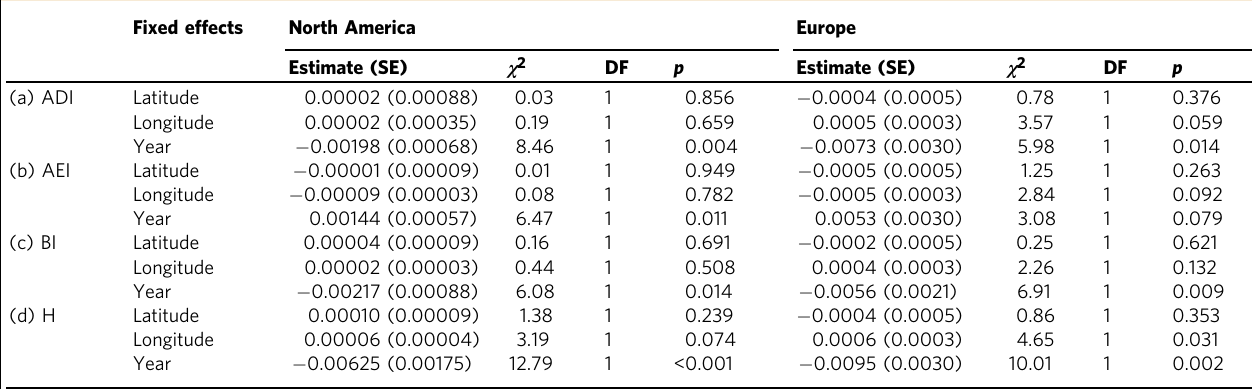
Table 3 Results of GLMMs of the variation in the acoustic properties of